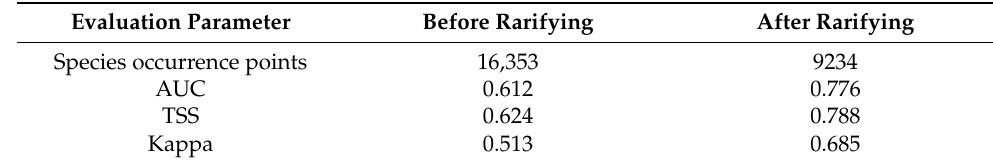
Table 2. Evaluation parameters of MaxEnt modeling of P . hysterophorus .